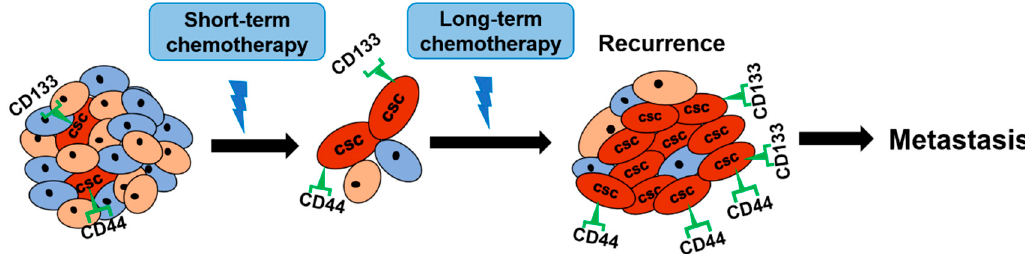
Figure 2. Regulation of drug resistance by cancer stem cells (CSCs). Short-term chemotherapy is effective to most cancer cells but not CSCs. During long-term chemotherapy, CSCs expressing cell surface markers (CD44, CD133) are gradually increased, which might cause tumor recurrence and metastasis.